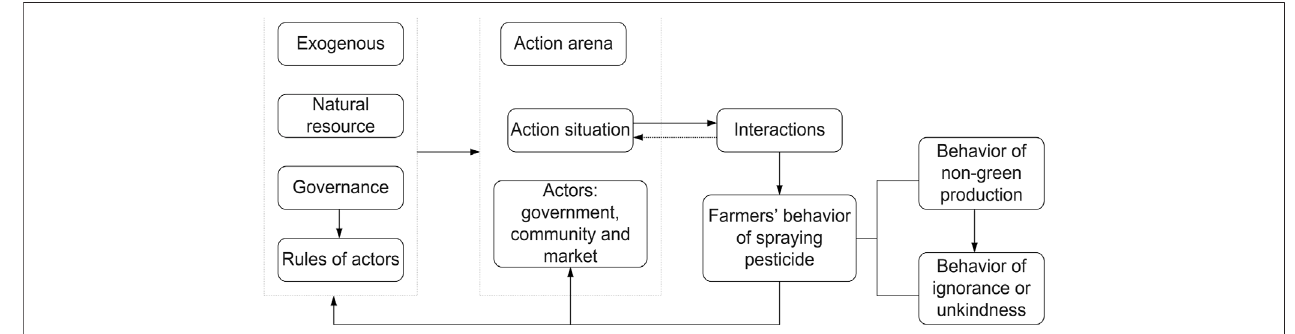
FIGURE 1 | Theoretical framework for assessing green production